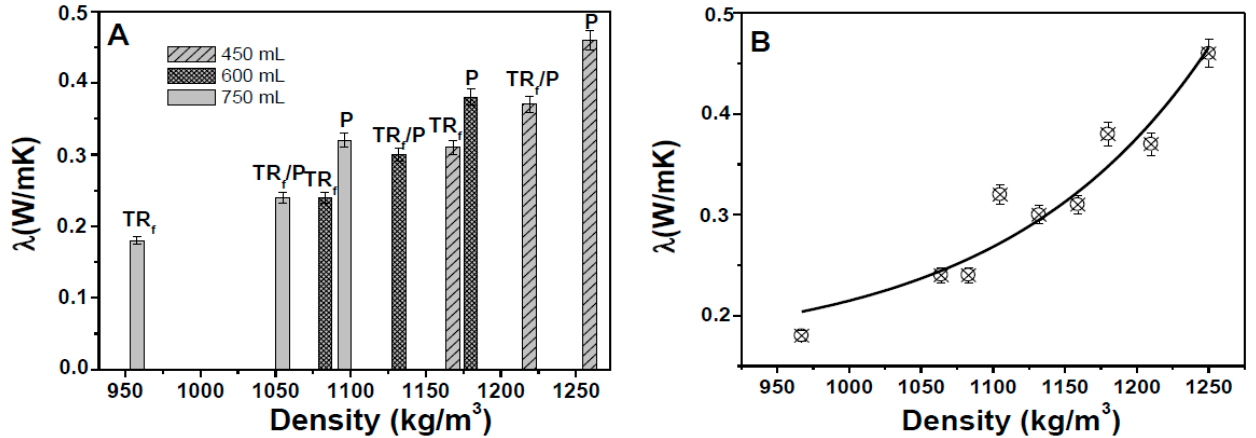
Figure 10. ( A ) Thermal conductivity of the TR F and perlite specimens. The thermal conductivity of the sand reference was ≈ 2 W/mK. ( B ) Exponential increase of the thermal conductivity with the density increase.